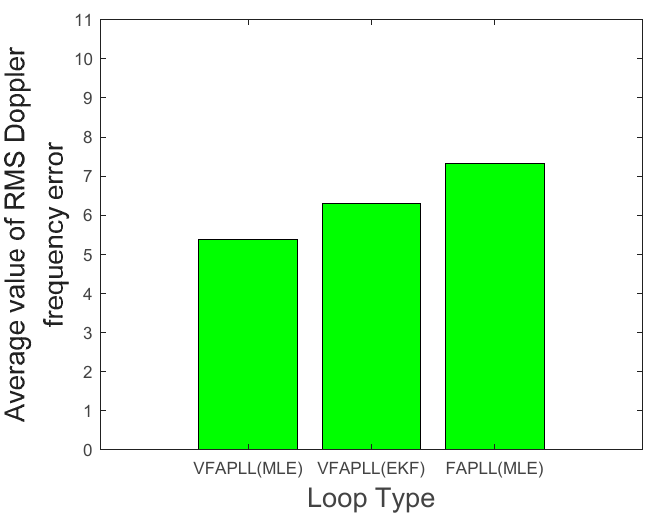
Figure 8. Comparison of the mean values of the VFAPLL (MLE), VFAPLL (EKF) and FAPLL (MLE) RMS Doppler frequency errors under different acceleration scenarios when CNR = 23dB/Hz.